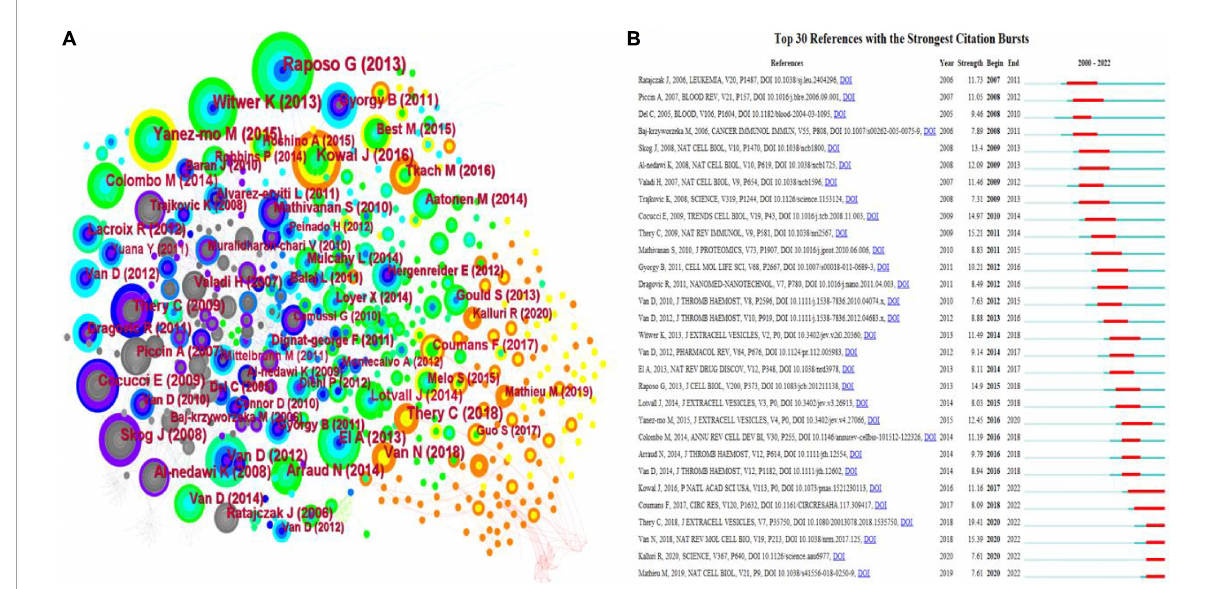
FIGURE7 A visualization map of co-cited references in platelet exosome research. (A) CiteSpace-based collaboration between co-cited references. (B) The top 30 references with the strongest citation bursts are based on